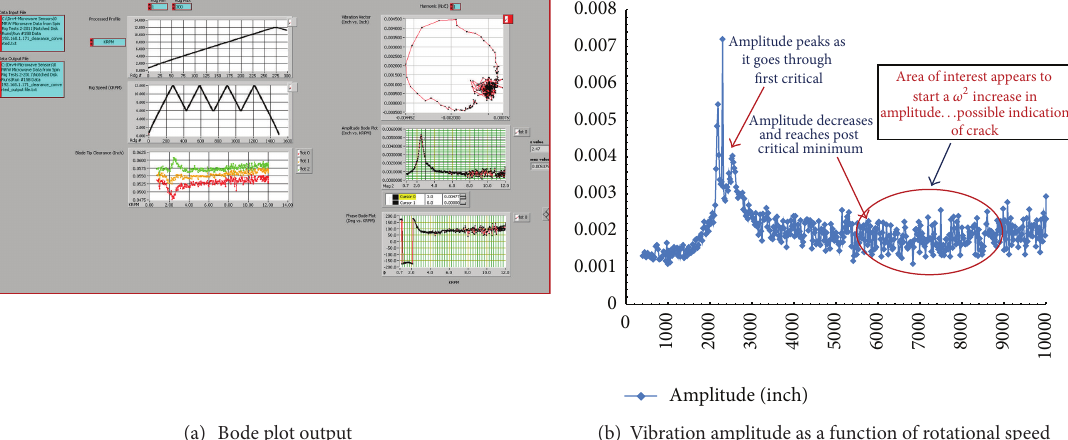
Figure 7: Simulated engine mission history profile (constant amplitude) test, microwave sensor